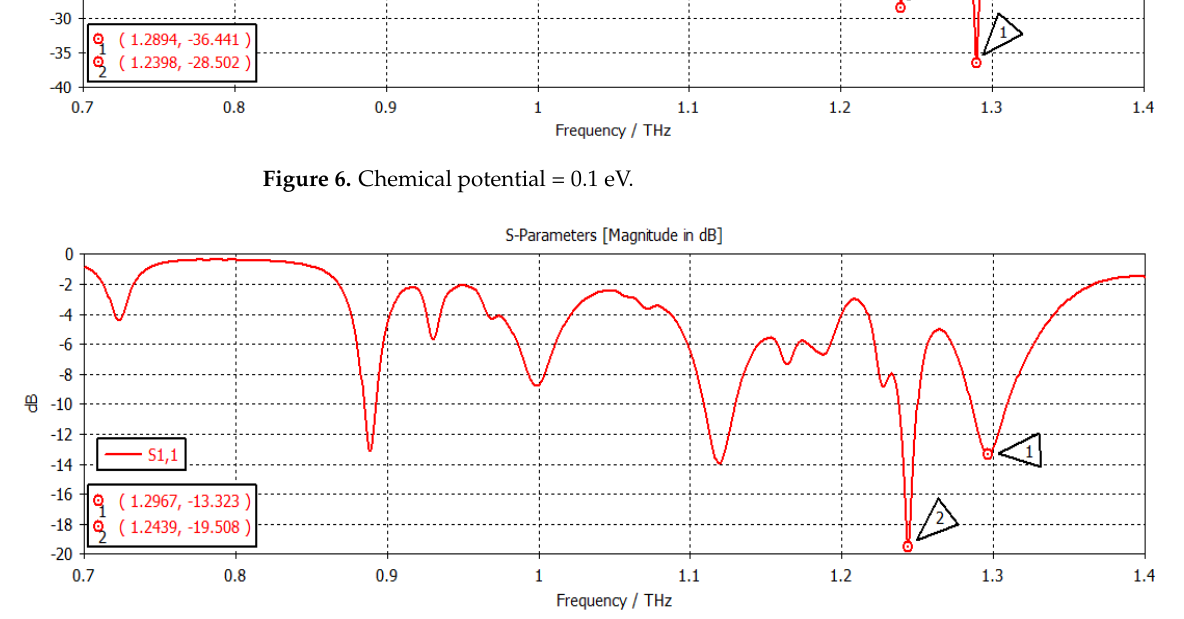
Figure 7. Chemical potential = 0.2.